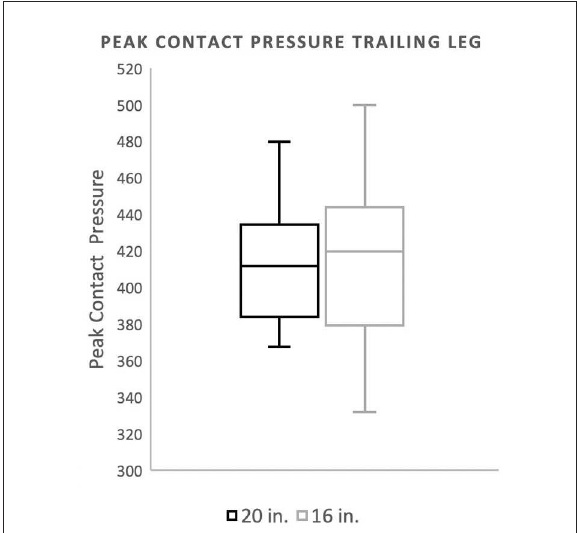
FIGURE6 Mean peak contact pressure of the trailing forelimb. There was no significant difference between the standard (20 ′′ ) or preferred (16 ′′ ) height for the trailing forelimb.